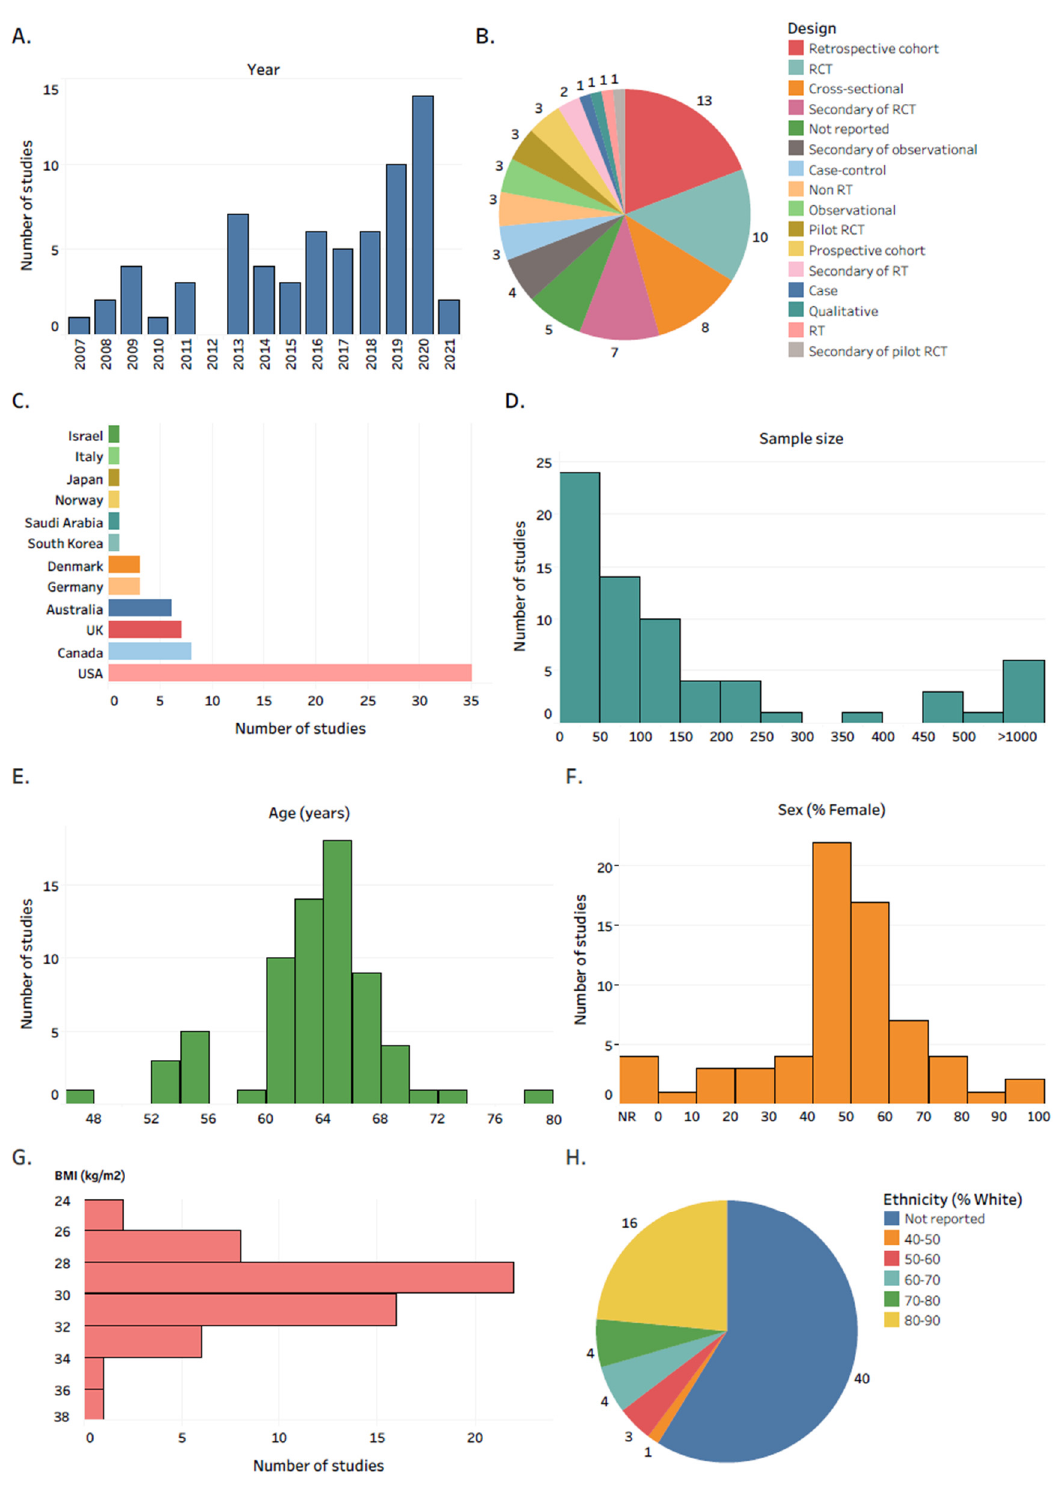
Figure 2. General study and population details. The number of studies by: ( A ) year of publication; ( B ) study design; ( C ) country; ( D ) sample size; ( E ) mean age; ( F ) percentage of female participants; ( G ) mean BMI; ( H ) percentage of participants of white ethnic background. Abbreviations: RCT, randomized controlled trial; RT, randomized trial; BMI, body mass index; NR, not reported. Interactive version of the figure with all the study references is located here: https://public.tableau.com/app/profile/tomasz.cudejko/viz/Figure2_16288559308710/Figure2 (accessed on 19 October 2021).